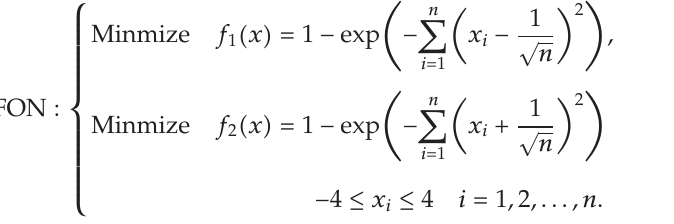
Scha ff er and Fonseca and Fleming used a two-objective optimization problem (cid:3) FON (cid:4) (cid:6) 18, 19